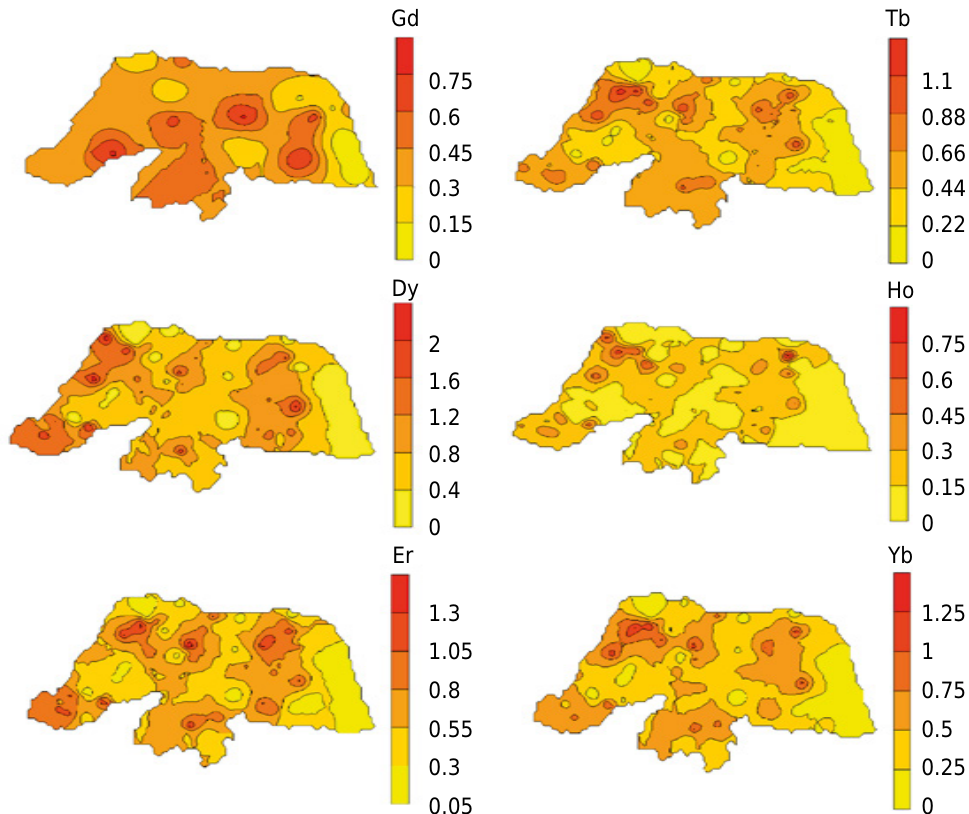
Figure 7. Spatial distribution of HREEs (mg kg -1 ) in soils from Rio Grande do Norte,